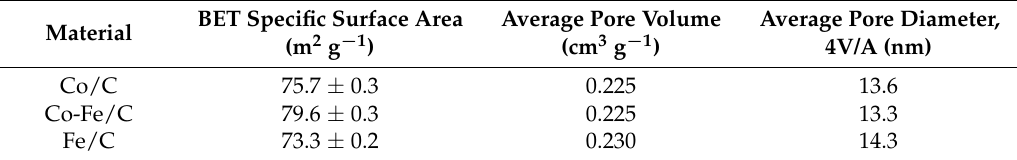
Table 2. The catalyst porosity analysis by the BET method.